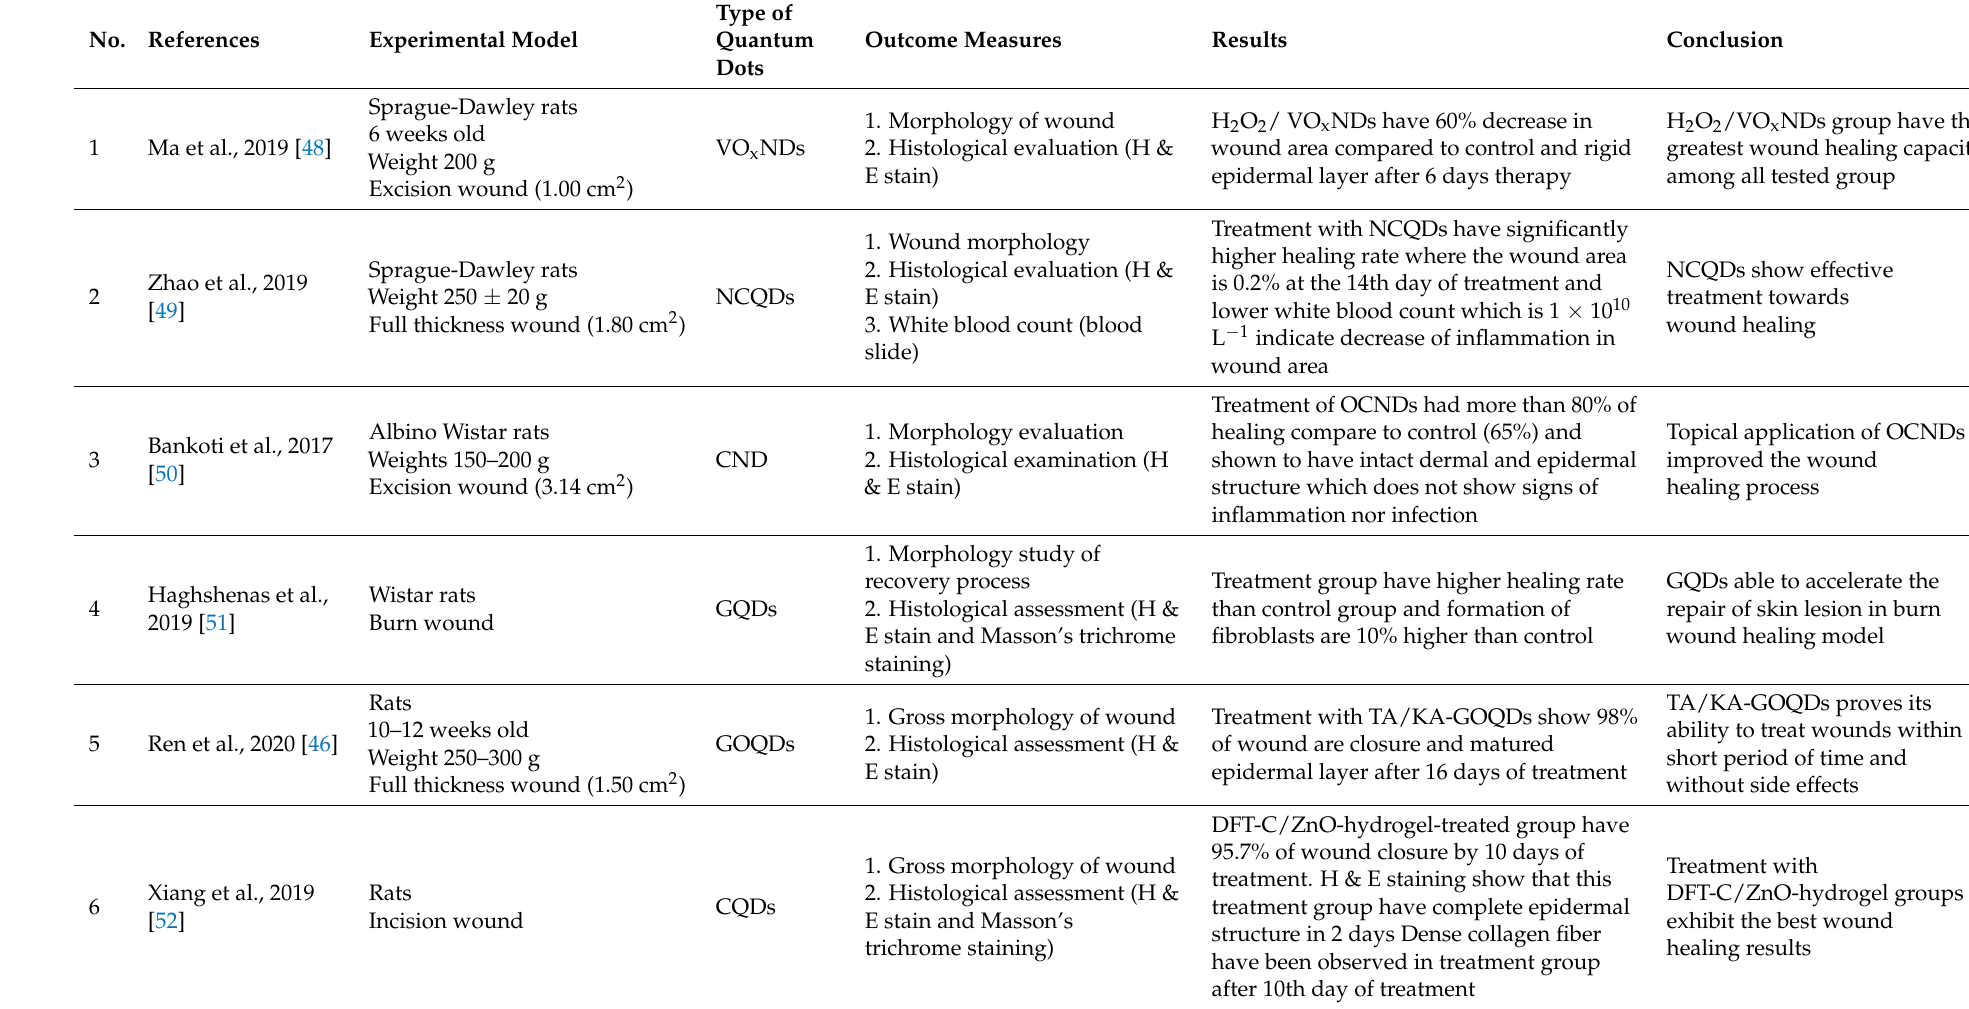
Table 2. In vivo study on wound